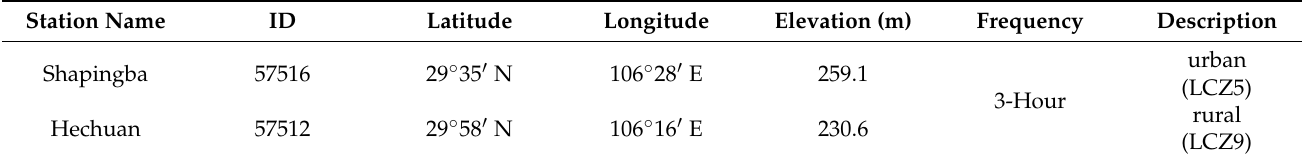
Table 1. Detailed information about the 2 meteorological stations.